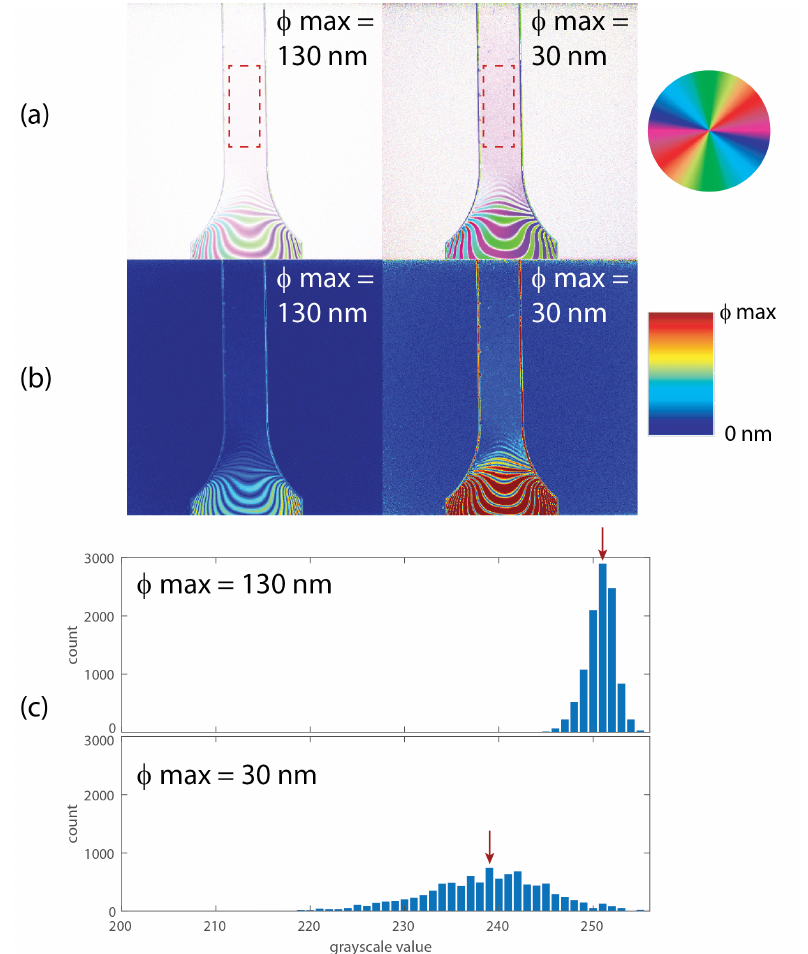
Figure 6. ( a ) Alignment angle and ( b ) retardation images for a polycarbonate specimen using two different maximum retardation angle limits. Region of interest shown as dashed rectangle in ( a ). ( c ) Histograms of pixel distribution in grayscale versions of alignment images for region of interest. Mean pixel value shown with a red arrow. No pixel values were calculated below